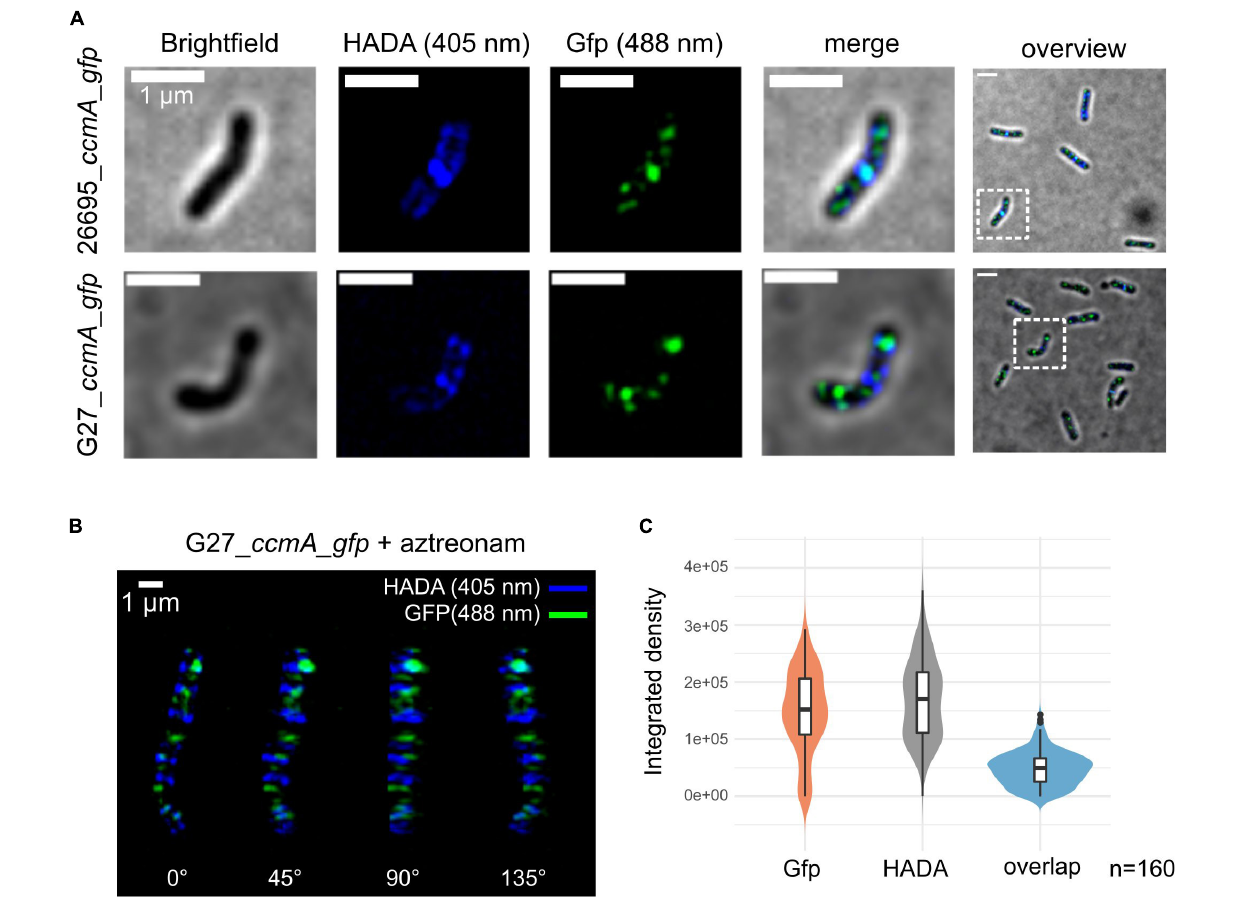
FIGURE 2 | Structured illumination microscopy of 26695_ccmA_gfp and G27_ccmA_gfp. Exponentially growing cells were pulse-labeled with HADA and images were reconstructed from three rotation angles (A) Brightfield, HADA (blue) and GFP (green) channels of exemplary 26695_ccmA_gfp (upper lane) and G27_ccmA_gfp (lower lane) cells. (B) 3D-view of aztreonam-treated G27_ccmA_gfp cell containing multiple growth rings. (C) Violin plot of integrated density distributions of the HADA- and Gfp signals compared to overlapping regions of 26695_ccmA_gfp